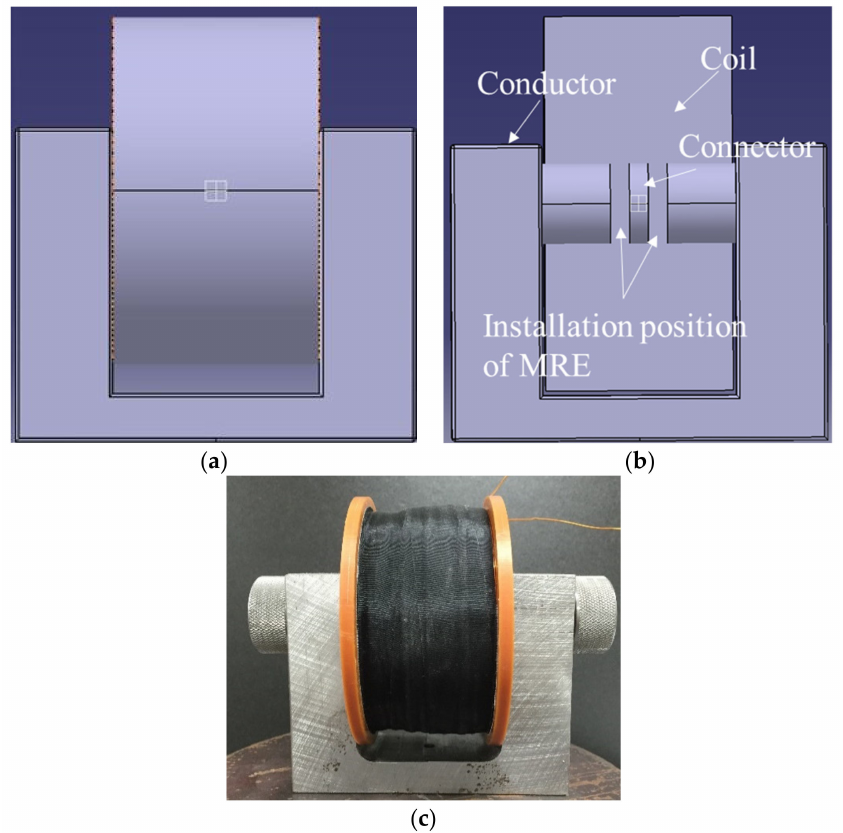
Figure 17. Optimized model of adaptive tuned MRE vibration absorber. ( a ) CAD model, ( b ) cross sectional view, ( c )